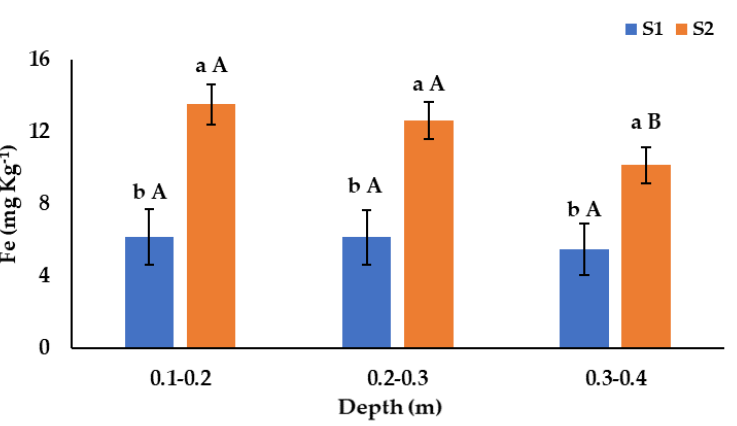
Figure 3. Interaction between depth (D) and soil type (ST) for soil Fe concentration (mg kg − 1 ). The comparison between the soil type in each depth is assessed with lowercase letters. The comparison between each type of soil at different depths is assessed with capital letters.